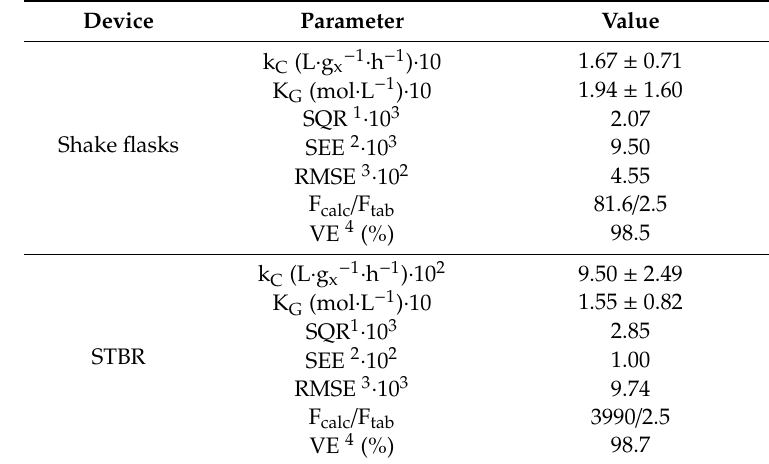
Table 5. Kinetic and statistical parameters calculated for high agitation experiments with the reaction rate control of the overall process rate. Runs 16 to 18 (shake flasks) and 22 to 24 (STBR). Model Equation (6). RMSE: residual mean square error, SQR: sum of residuals, SEE: standard error of estimates, VE: percentage of explained